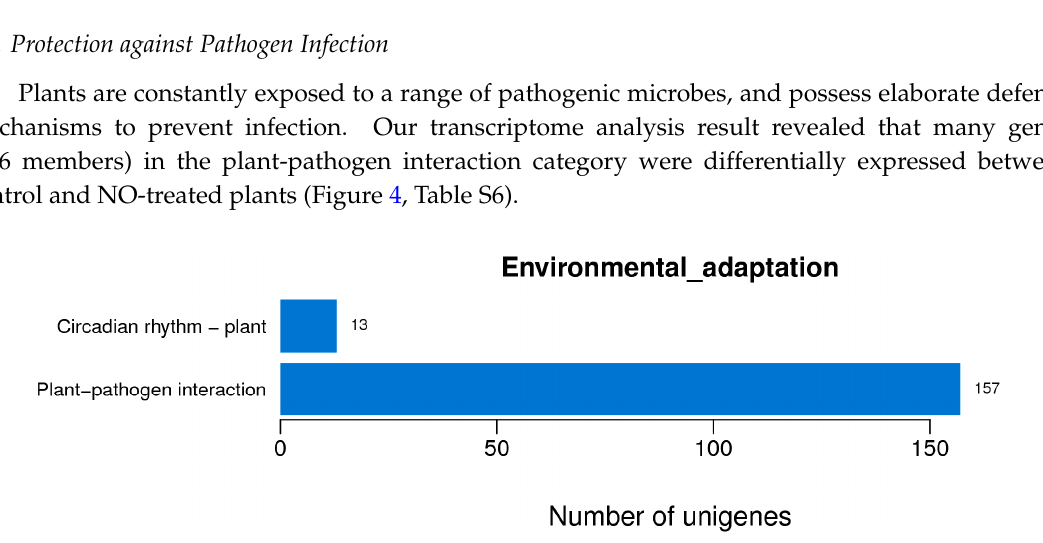
Table 1. Gene pathways enriched in the top 50 highly expressed genes.